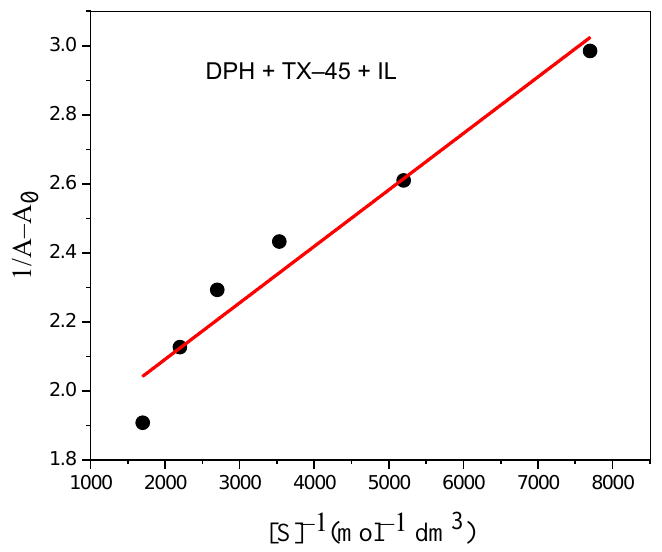
Figure 4. Benesi-Hildebrand graph by utilizing the change in absorption spectra of DPH.